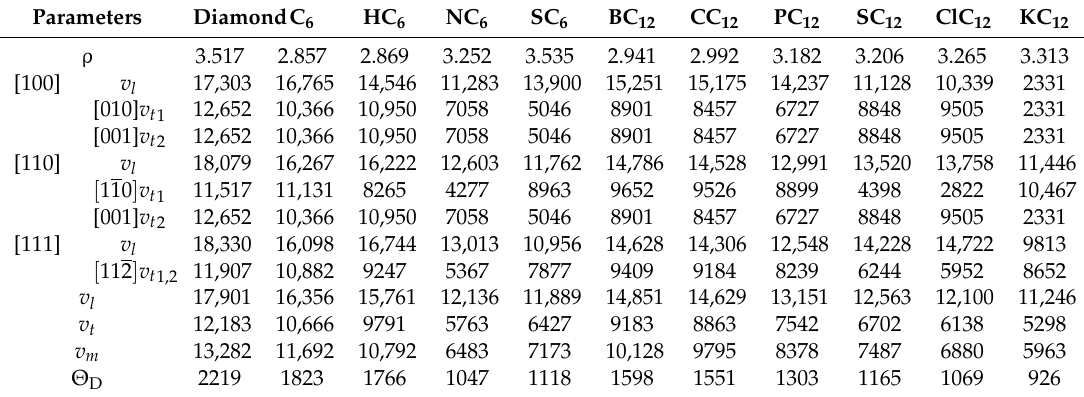
Table 3. Density (g/cm 3 ), anisotropic acoustic velocities (m/s) and average acoustic velocity (m/s). Parameters